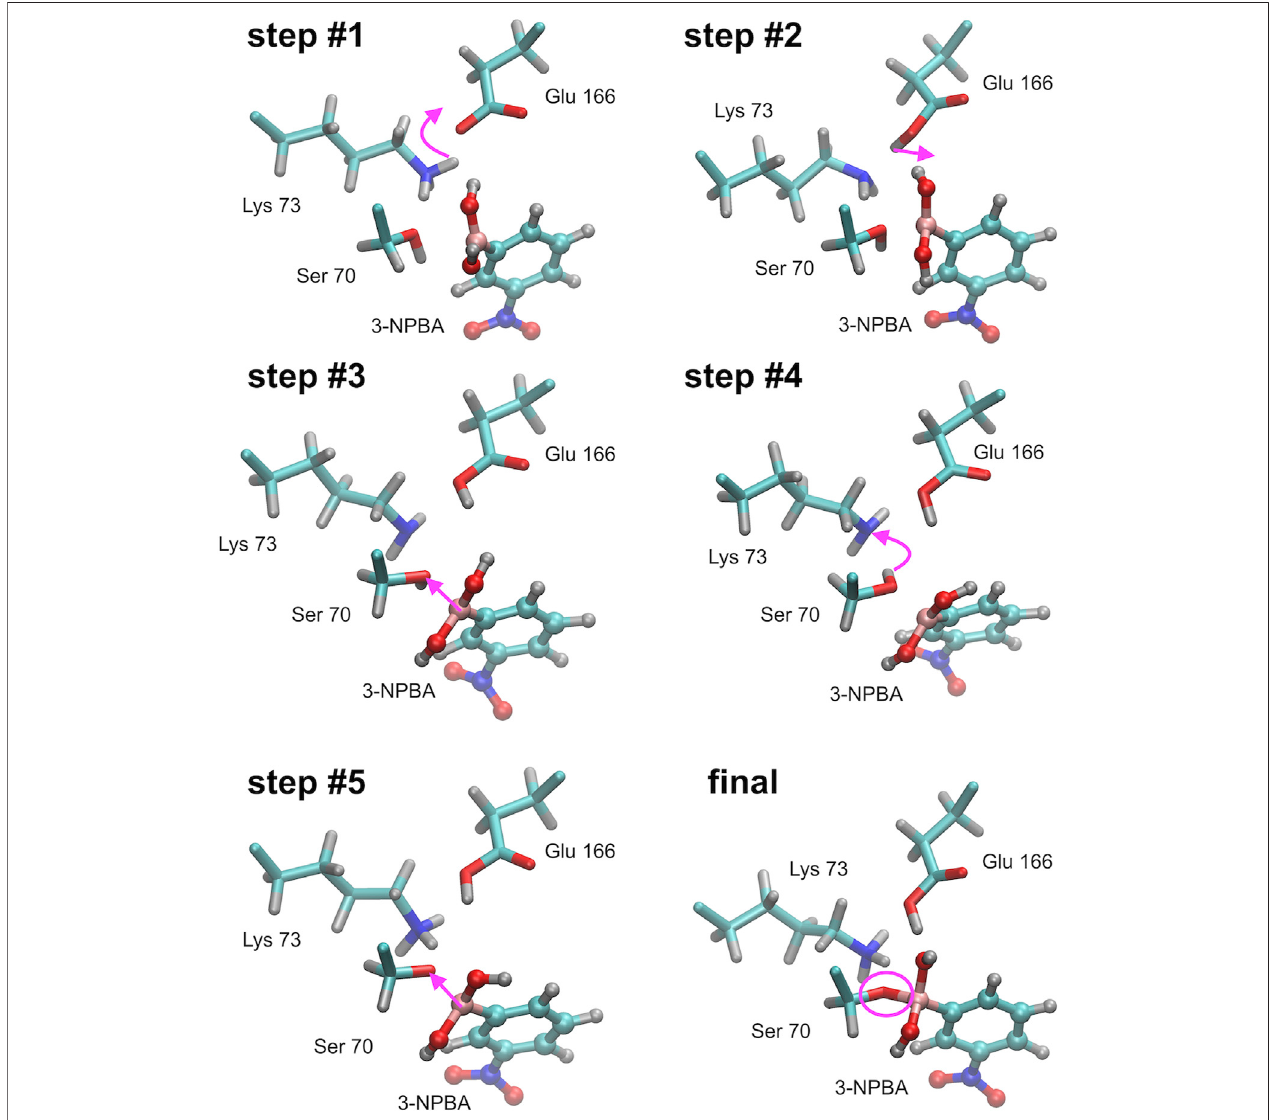
FIGURE 4 | Successive steps of the chemical reaction leading to the bond formation between the Ser 70 hydroxyl group of KPC-2 β -lactamase, and the boron atom of 3-NPBA. Most important molecular and atomic labels are given in Figure 6 (Class A). Curved arrows indicate the proton transfer processes, straight arrows indicatedistancereduction.Step#1 – protontransferfromLys70toGlu166(Ser70-3-NPBA-borondistance,2.1 Ă ).Step#2 – protonlocationrearrangementleading to hydrogen bond formation with 3-NPBA-boron (Ser 70 - 3-NPBA-boron distance, 2.1 Ă ). Step #3 – the boron atom moves towards the Ser 70 hydroxyl group (Ser 70 - 3-NPBA-boron distance, 1.6 Ă ). Step #4 – proton transfer between Ser 70 and Lys 73 (Ser 70 - 3-NPBA-boron distance, 1.6 Å). Step #5 – a movement of the boron atom towards the Ser 70 hydroxyl group (Ser 70 - 3-NPBA-boron distance, 1.5 Å). Final structure – the chemical bond is formed between the hydroxyl oxygen of Ser70andtheboronatomof3-NPBA(Ser70-3-NPBA-borondistance,1.50 Å).Step#4andstep#5canbedescribedasrepresentativesoftheleadingtransitionstate on the reaction